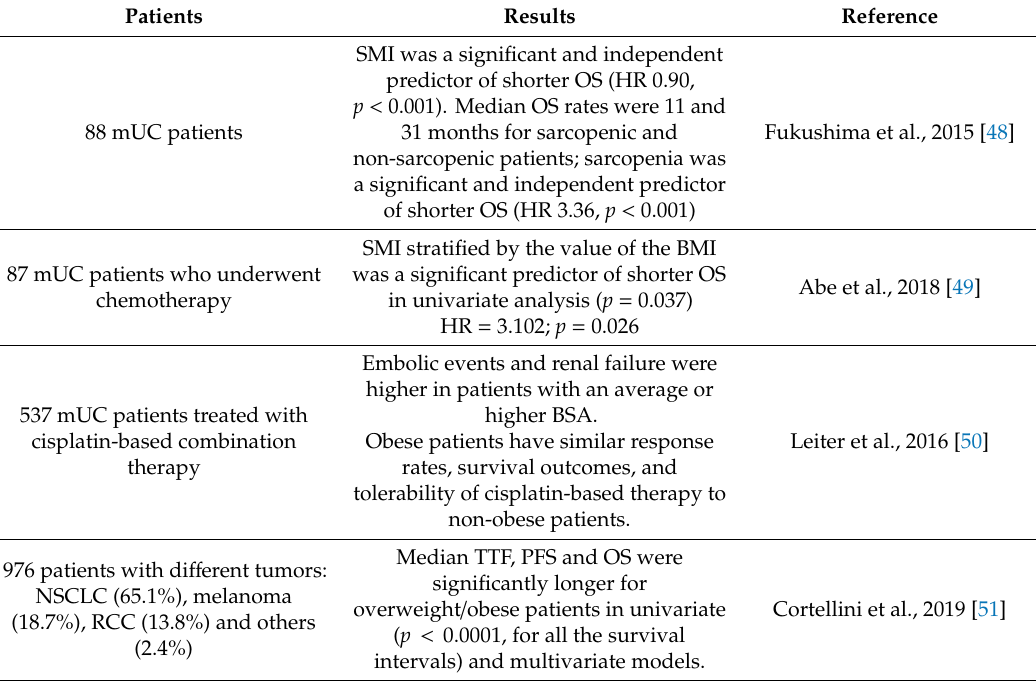
Table 1. BMI and response of urothelial cancer to chemotherapy and